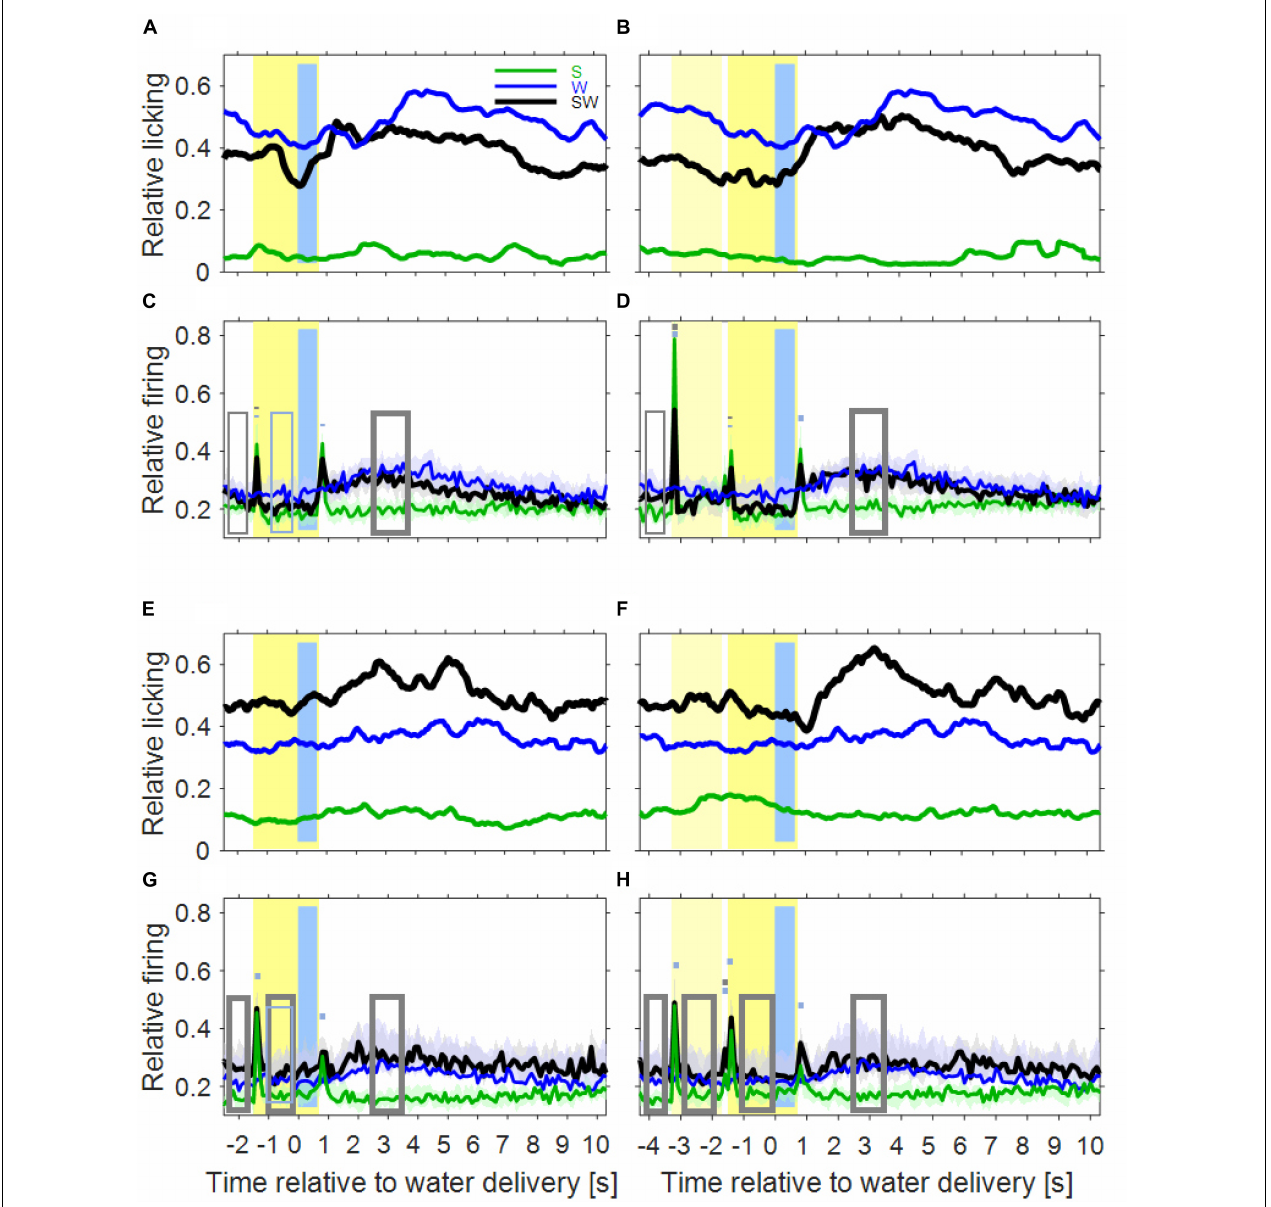
FIGURE 2 | Licking activity and auditory cortical firing rates differ between the three conditions of the simple block. In the first row, the plots show the licking activity of six experimental sessions in the instrumentally-trained monkey B for the S-condition (green), the W-condition (blue), and the SW-condition (black) in tone-alone trials (A) and in noise-tone trials (B) . Note that the blue curves are identical in tone-alone and noise-tone trials already from 2.5 s before water delivery. Other conventions as in Figure 1 . (C,D) Show the median population firing rates of 97 multiunits in the two instrumentally-trained monkeys. The shadings show the 95% range of the median. The rectangles and the short bars denote time intervals in which there was a significant difference in firing rates between the S and SW condition (gray) or between the W and SW condition (blue). Thin lines indicate p < 0.01; thick lines indicate p < 0.001. (E,F) Show the licking activity of fourteen sessions in the two passive monkeys. (G,H) Show the population firing rates of 75 multiunits in the two passive